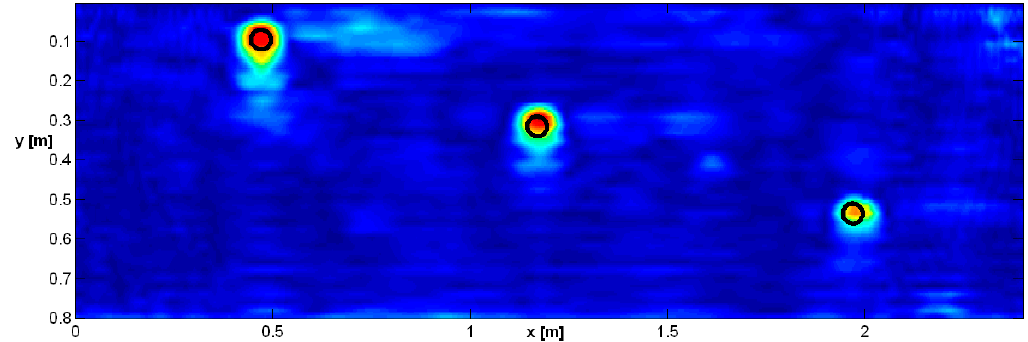
Figure 9. Reconstruction achieved with three adjacent investigation-observation domains (0.8 m long).